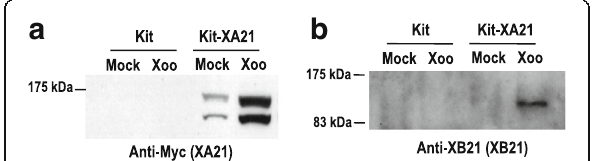
Fig. 2 Rice XB21 interacts with XA21 in vivo . XB21 co-immunoprecipitated with XA21 protein before (Mock) and after Xoo inoculation ( Xoo ) in Kitaake (Kit) and transgenic rice carrying Myc-XA21 under the control of its native promoter (Myc-XA21, T330-16-1). The precipitates were used for western gel blot analysis using anti-Myc antibody ( a ) or anti-XB21 antibody ( b ). Myc-XA21 and its cleavage product displayed bands at approximately 140 and 100 kDa, respectively, and XB21 was detected as approximately 110 kDa band. Experimental results were repeated three times, with